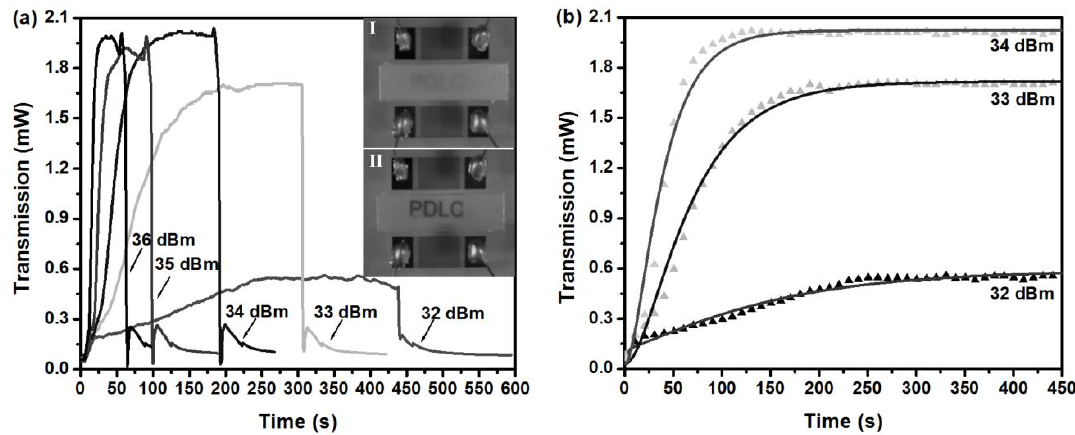
Figure 3. ( a ) Transmission as a function of time showing the switching process with varying power of surface acoustic waves (SAWs). The insets illustrate that the polymer-dispersed liquid crystal (PDLC) film is opaque without SAW and becomes transparent with SAW. ( b ) The enlarged view with time from 0 S to 450 S showing the switch-on process with theoretical fitting. Reproduced with permission from [86]. Copyright John Wiley & Sons, 2011.